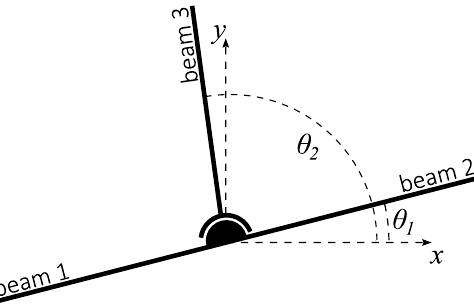
Figure 1. Scheme of an example on/off controllable